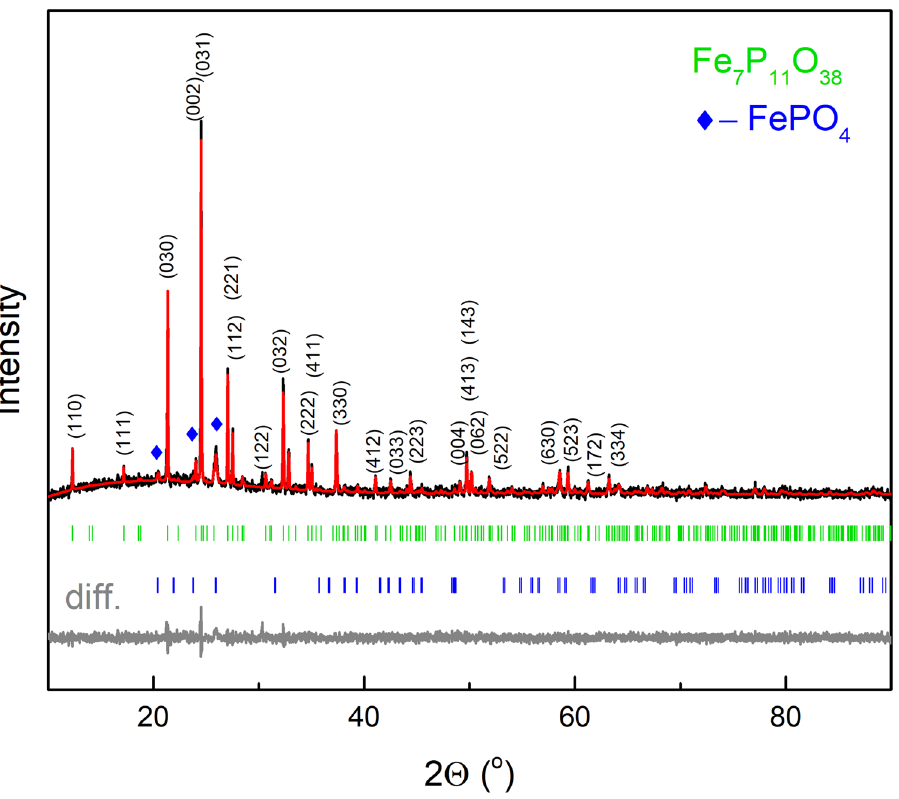
Figure 1. Measured X-ray diffractogram (black) of the crystalized sample (new phase Fe 7 P 11 O 38 and traces of FePO 4 ) with fitted (red) and differential (gray) patterns. Green and blue ticks in the figure represent theoretical positions of Bragg peaks for Fe 7 P 11 O 38 and FePO4, respectively. The most intense Bragg peaks of FePO 4 are marked with blue